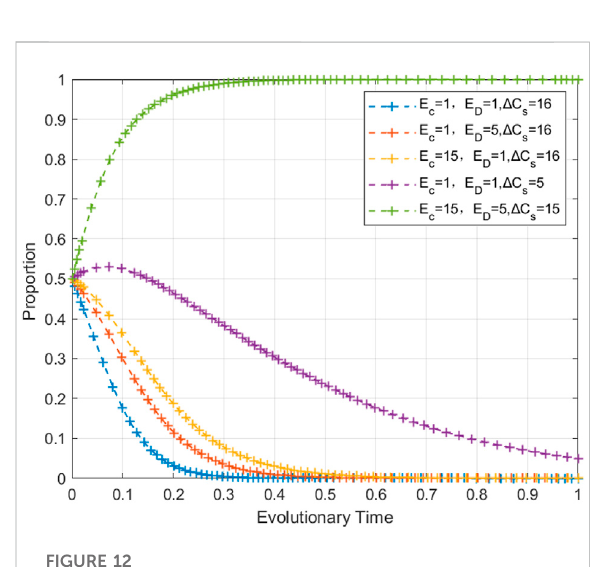
FIGURE 13 In fl uence of Δ Hr , B D and Δ H C on the evolution of